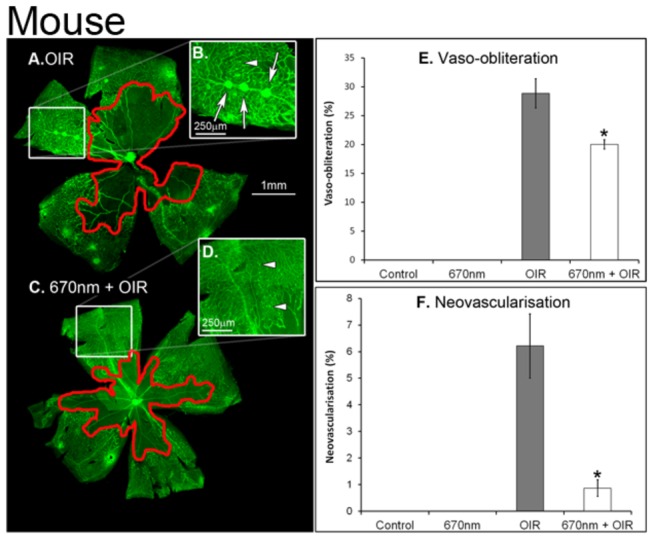
Quantification of vascular abnormalities in P17 c57BL/6J mouse lectin stained retinal wholmounts.(A, B) OIR shows increased vaso-obliteration (E) and neovascularisation (F) compared to 670nm + OIR (C, D). Neovascularisation was reduced to almost control levels in the 670nm+OIR retina (F). Red (A, C) areas show vaso-obliteration, while white arrows show large neovascular tuffs and white arrows show small tufts. * indicated statistical significance p<0.05. Error bars show standard error. P – postnatal day, OIR – Oxygen induced retinopathy. Graph bar fills indicate controls (black), 670nm treated (dark grey), OIR (light grey) and 670nm+OIR (white).